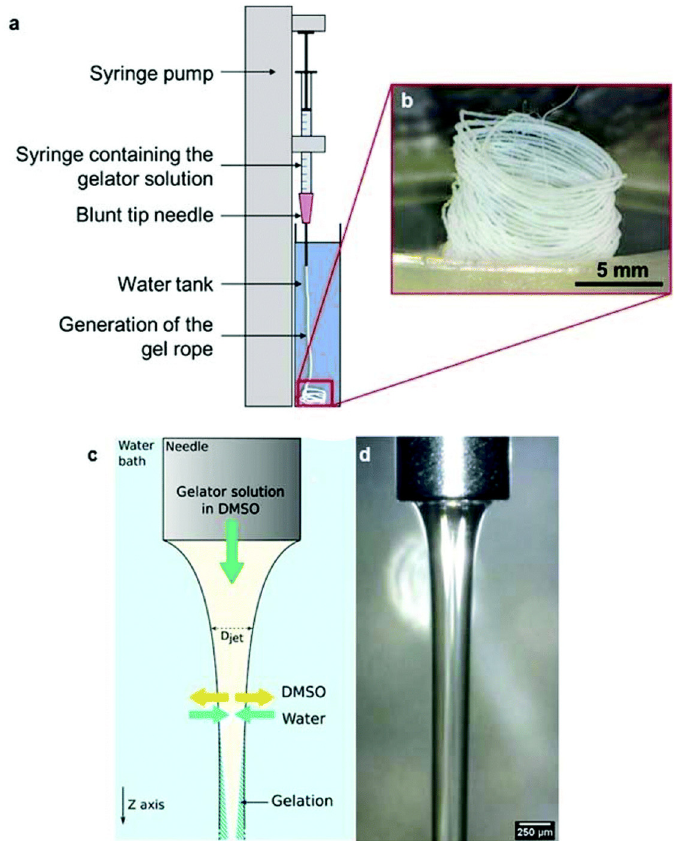
Figure 79. ( a ) Apparatus setup for wet spinning gel. ( b ) Magnification of the coiled gel filament after extrusion, gelator solution: 4 wt % 31b solution in DMSO (50 μ L min − 1 , 20 G needle, ID 600 μ m. ( c ) Schematic explanation of the wet spinning method. ( d ) Image of the DMSO jet after escap-